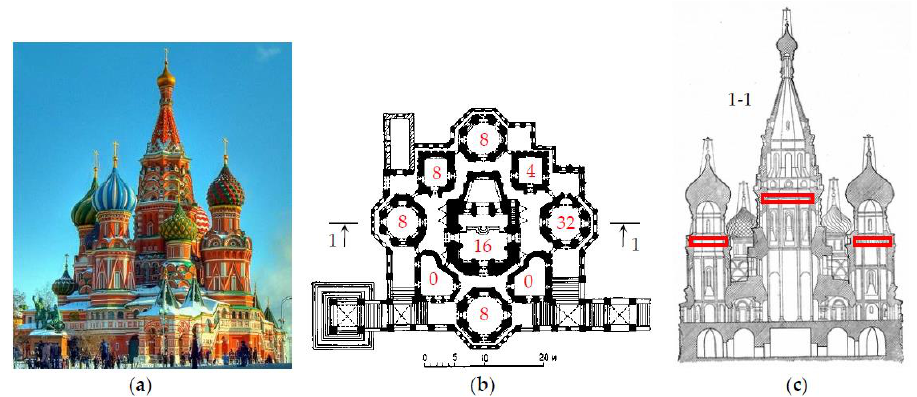
Figure 2. St Basil’s Cathedral ( a ), the plan of its second floor ( b ) and the central section ( c ). The numbers on the plan indicate the number of the vessels in each church, the red rectangles on the section mark the displacement of the vessel in the central church.